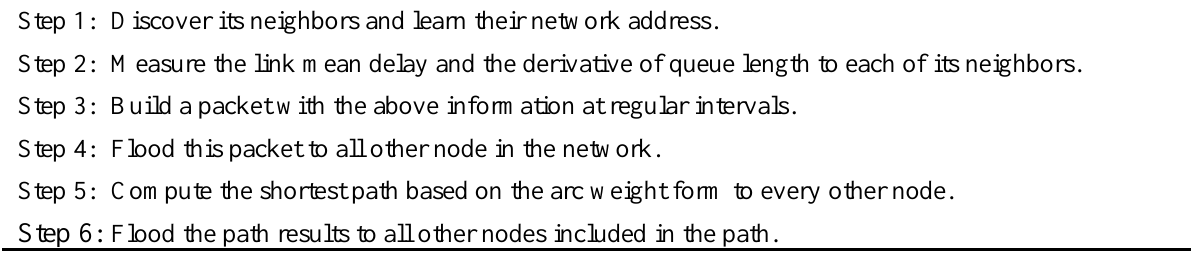
Table A2. Distributed routing protocol for each node.